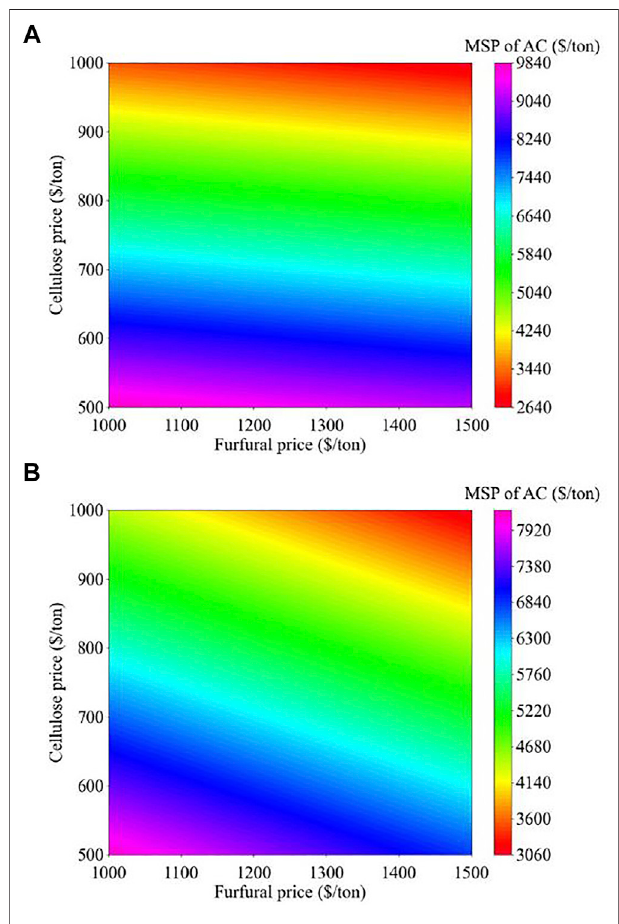
FIGURE 12 | Impact of furfural and cellulose price on the MSP of activated carbons produced in (A) YP and (B) SG-based biore fi neries.